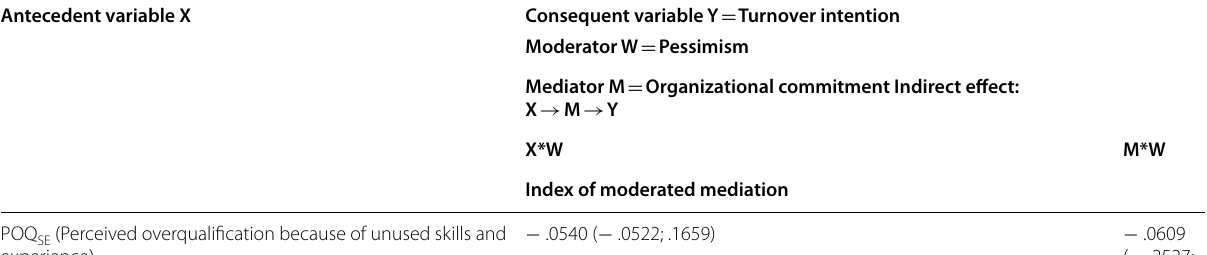
Table 9 Moderated mediation effect of POQ intention ; Pessimism as a